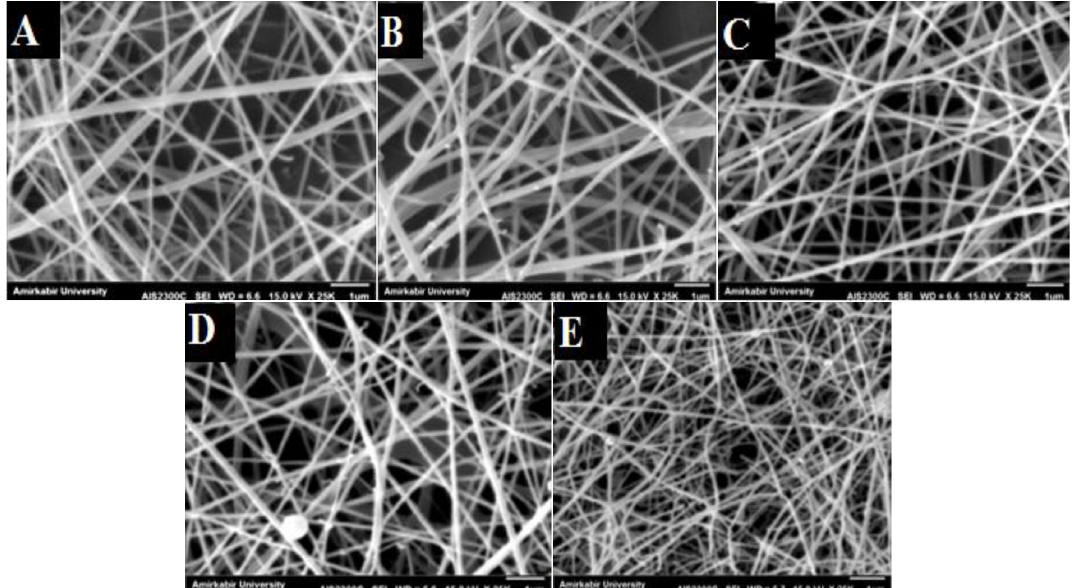
Fig. 4. SEM images of electrospun CS/PEO nanofibers without vancomycin(A), CS/PEO nanofibers with 0.2 g vancomycin(B), CS/PEO nanofibers with 0.4 g vancomycin(C), CS/PEO nanofibers with 0.6 g vancomycin(D) , CS/PEO nanofibers with 0.8 g